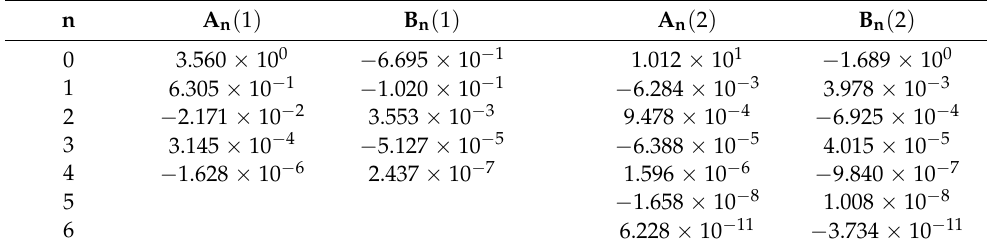
Table A13. Coefficients of the H 2 O-LiBr + LiNO 3 saturated pressure